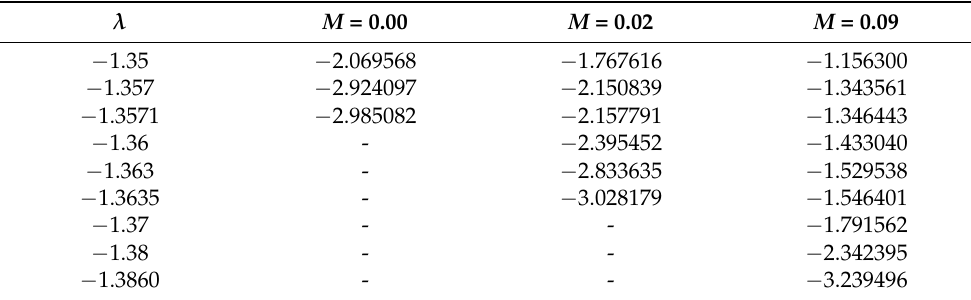
Table 5. Values of − θ (cid:48) ( 0 ) as φ 1 = φ 2 = 0.01, α = 3.0, β = 0.5, Ec = 0.1, and Pr = 6.2. λ M =